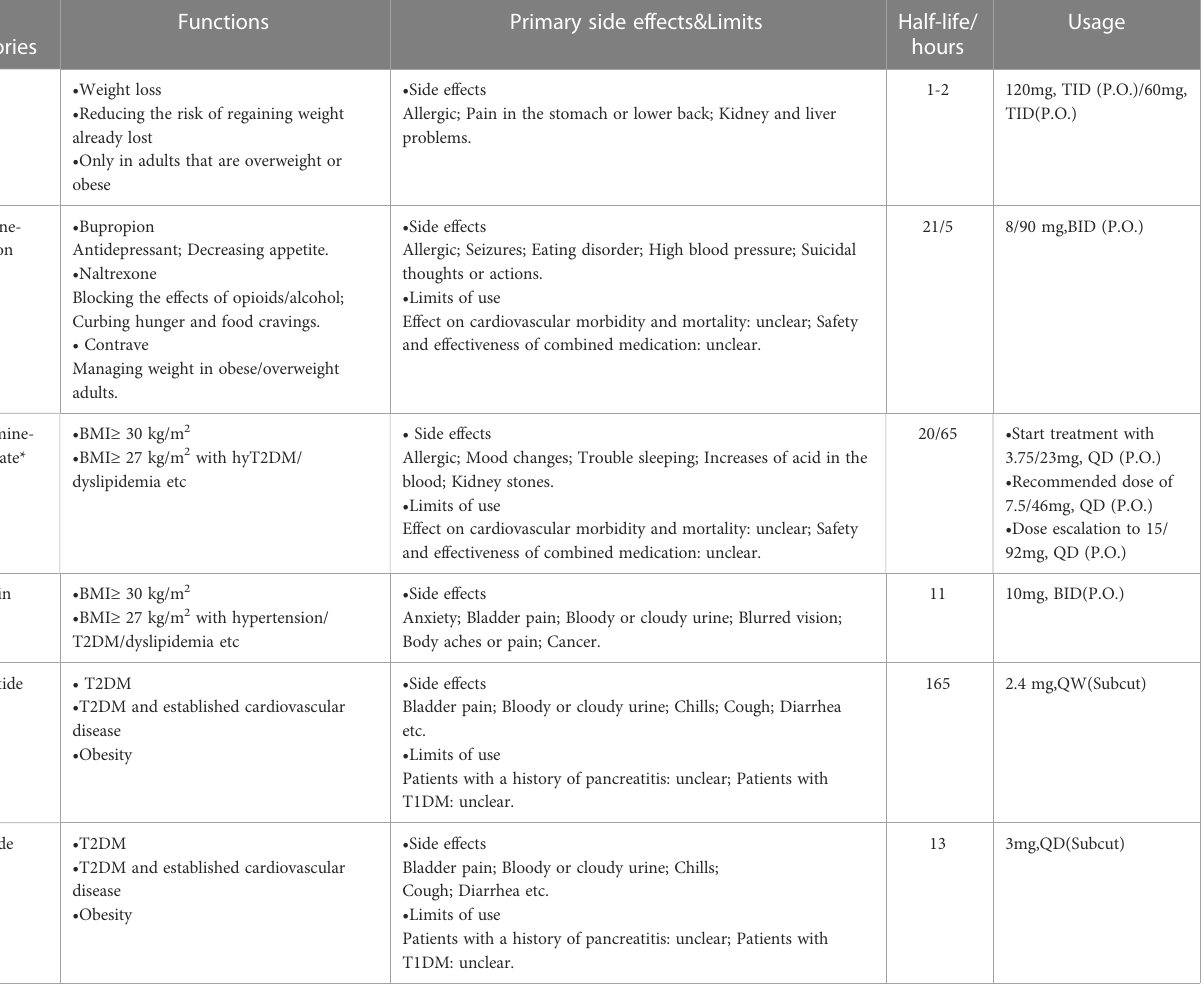
TABLE 1 Anti-obesity drugs: principal categories, functions, side effects, half-life and usage (20, 21). Major Categories